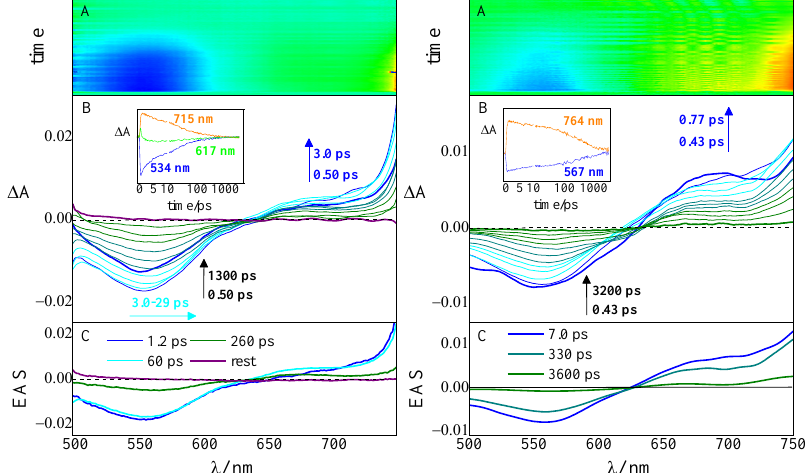
Figure 5. Pump–probe absorption spectroscopy of compound 6 in ETN buffer solution, pH 7.4, complexed with tRNA ( left graph ) and ct-DNA ( right graph ), r ([compound]/[nucleic acid]) = 0.005 ( λ exc = 400 nm): ( A ) contour plot of the experimental data, ( B ) time-resolved absorption spectra recorded at different delays after the laser pulse (inset: decay kinetics recorded at meaningful wavelengths), and ( C ) Evolution Associated Spectra (EAS) obtained by global analysis.